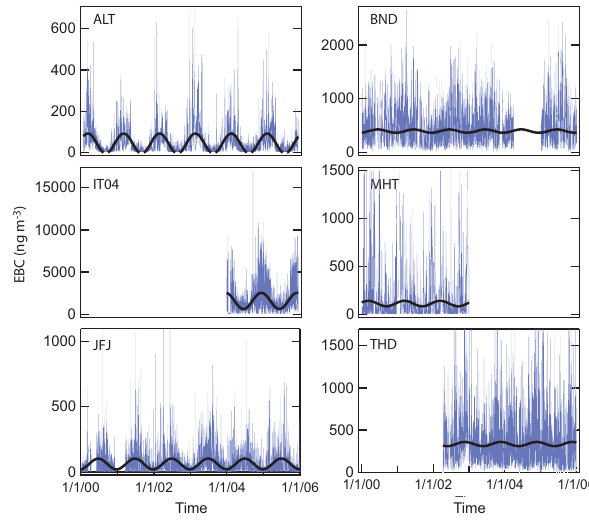
Fig. 1. Time series of EBC concentration (bleu) and sinusoidal fits (black) for available years at Alert (ALT), Bondville (BND), Ispra (IT04), Mace Head (MHT), Jungfraujoch (JFJ), and Trinidad Head (THD).